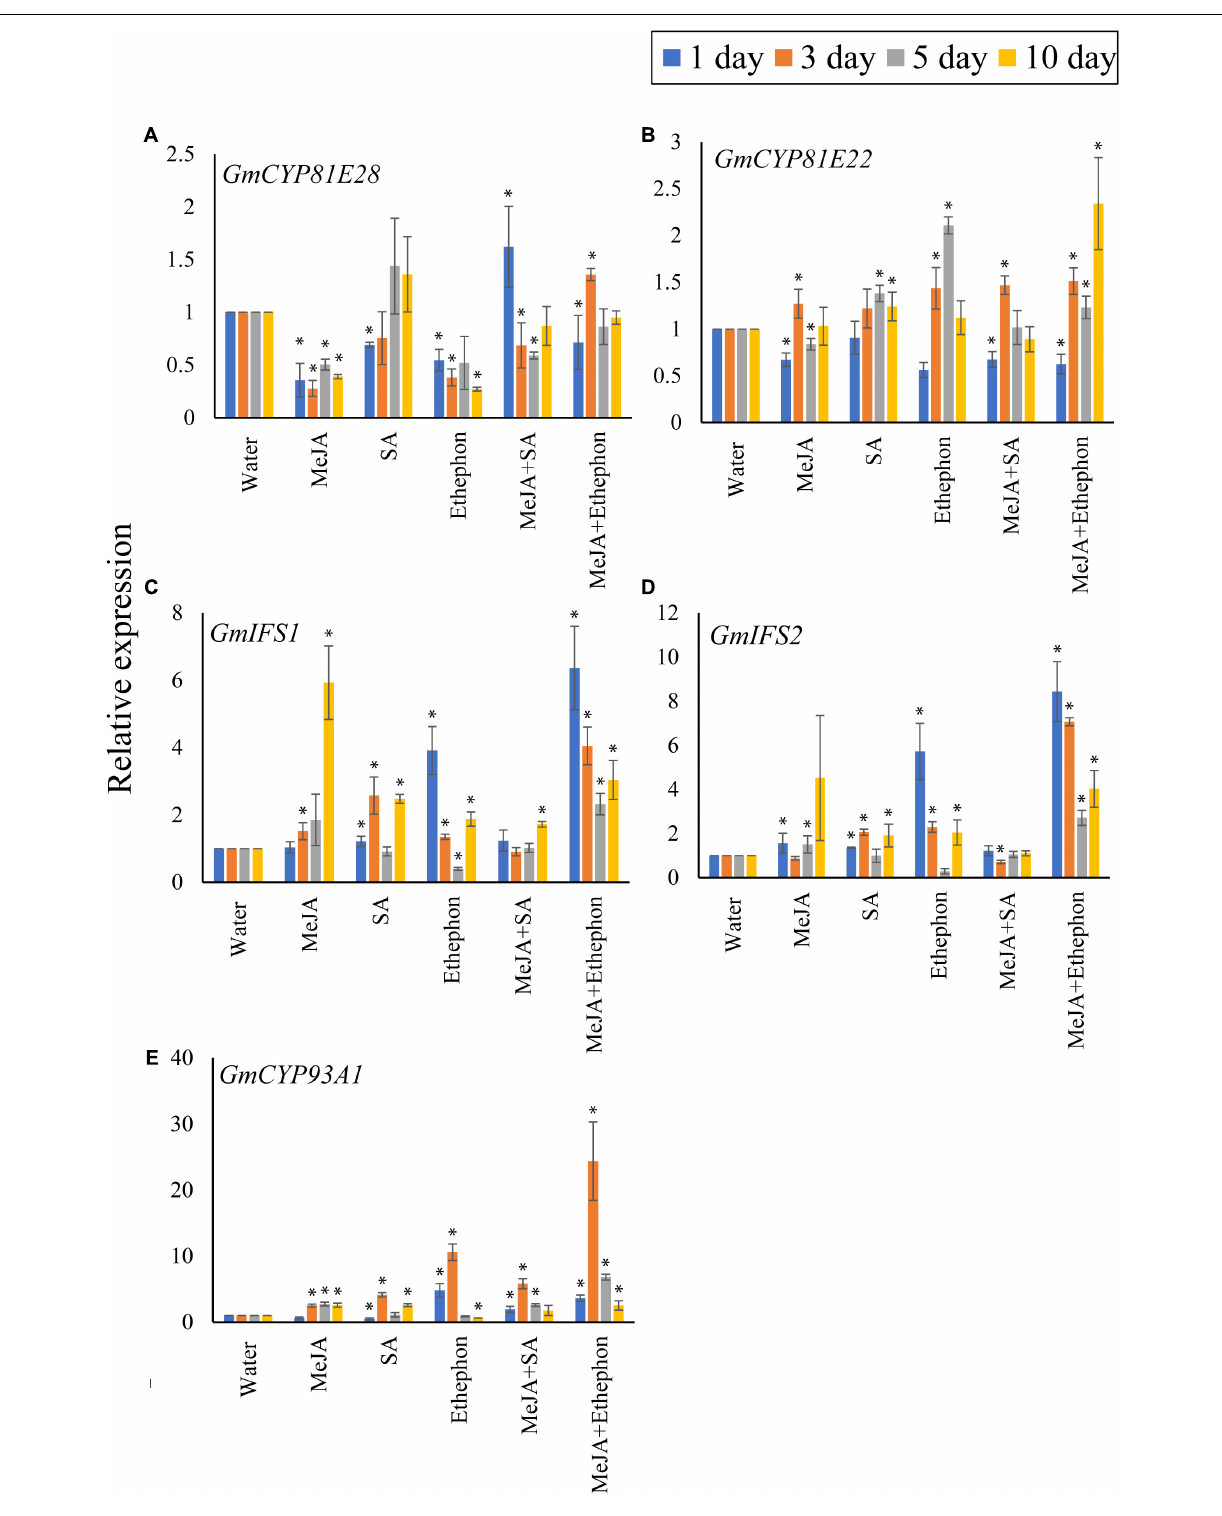
Frontiers in Plant Science |